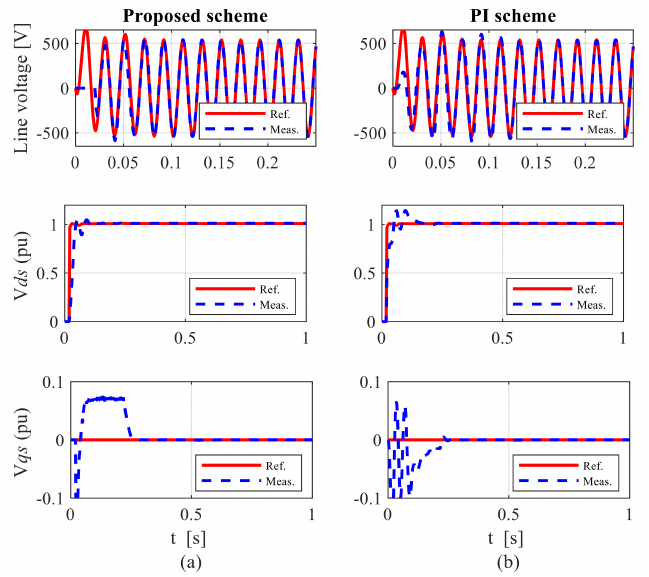
Figure 14. Control performances during super-synchronous speed operation under phase-angle variation: ( a ) proposed scheme and ( b ) PI